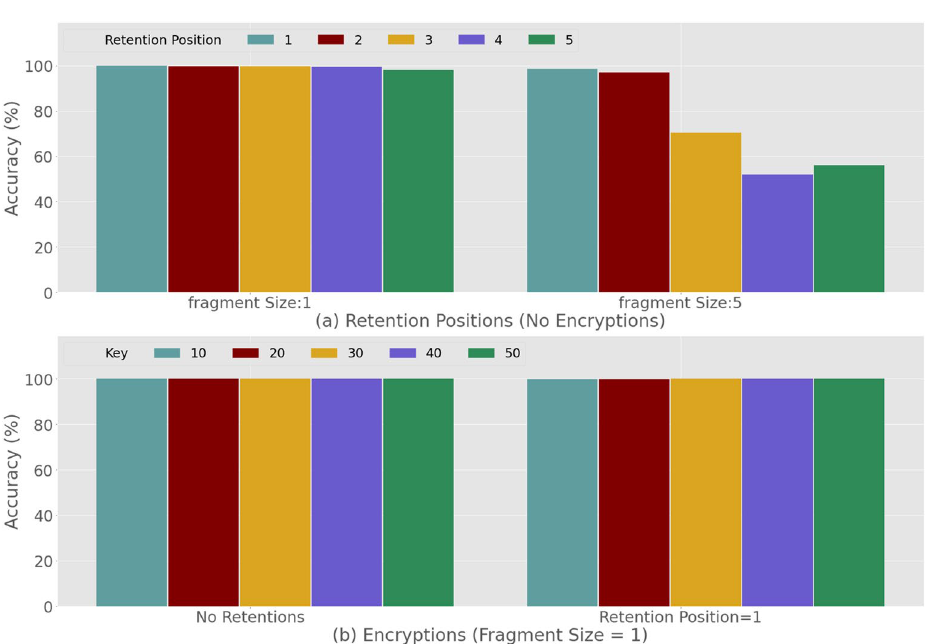
Figure 8. DNN-based detection of trigger samples amongst genuine E. coli plasmids: the impact of nucleotide retention ( a ) without encryption and ( b ) with encryption and with prior knowledge of the encryption key